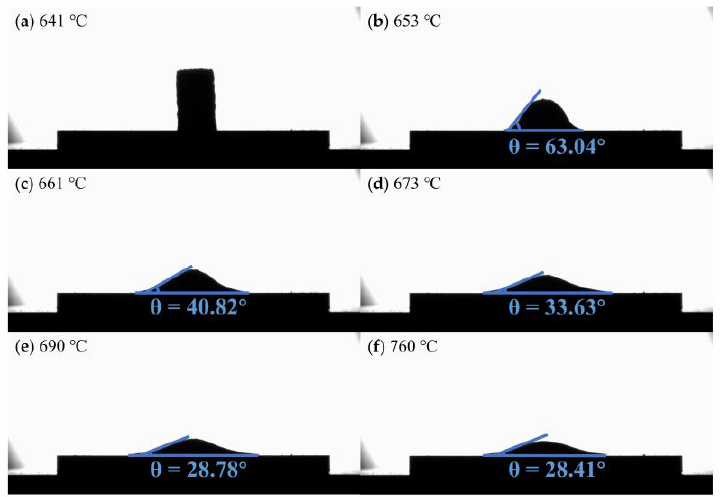
Figure 3. Images of the contact angle between flux #2 and alumina plate at different temperatures: ( a ) 641 ◦ C; ( b ) 653 ◦ C; ( c ) 661 ◦ C; ( d ) 673 ◦ C; ( e ) 690 ◦ C; ( f ) 760 ◦